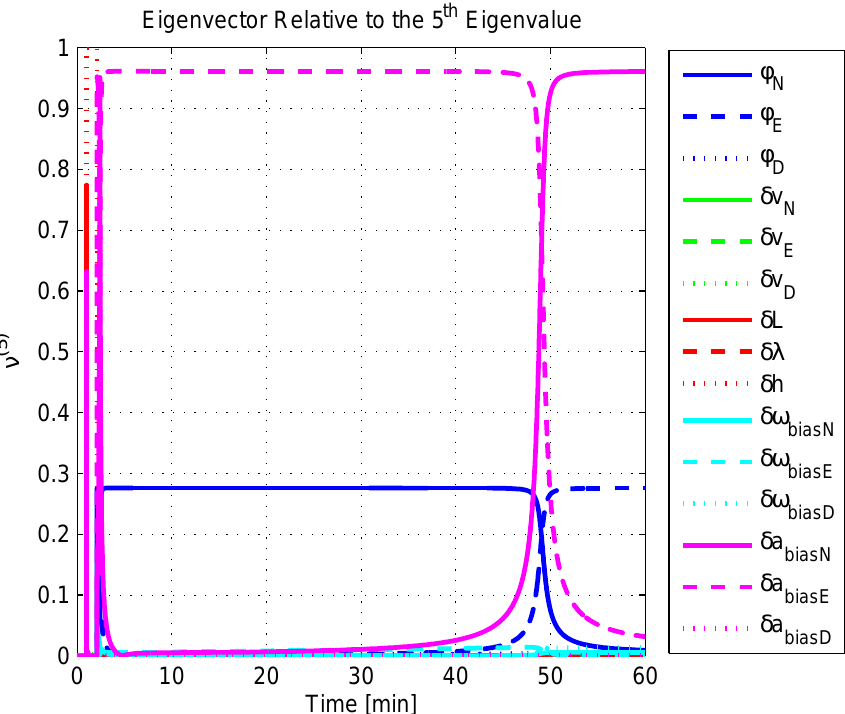
Figure 20. Eigenvector relative to the fifth eigenvalue in the experimental test.